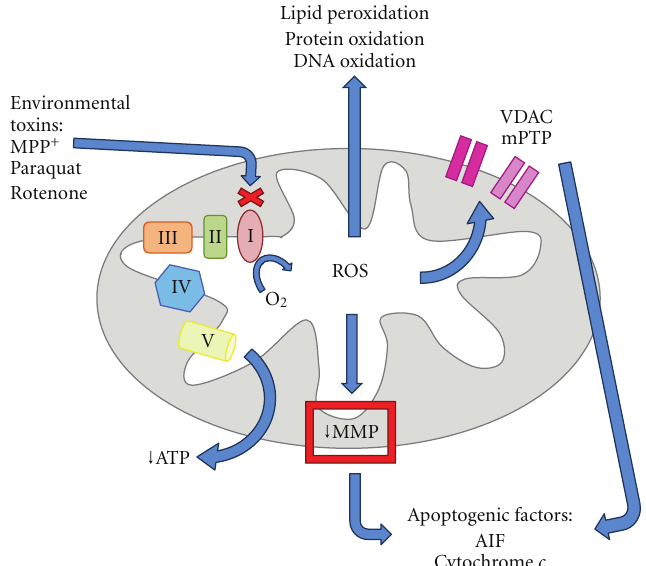
Figure 1: Environmental toxins cause the production of ROS by inhibiting complex I of the electron transport chain (ETC) and decrease the production of ATP. This ROS contributes to a loss in the mitochondrial membrane potential and well as disruption of mitochondrial permeability transition pores and voltage-dependant anion channels contributing to apoptosis. ROS also moves to the cytosol where it oxidizes proteins, DNA, and